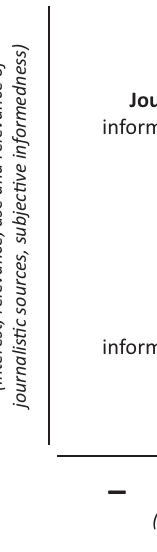
Figure 1. Types of information orientation among news